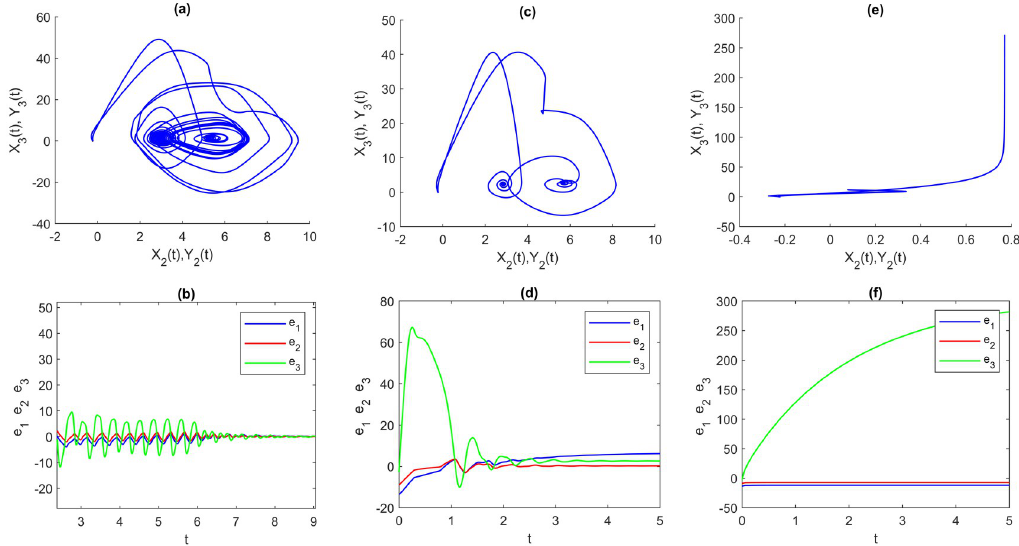
Fig 7. Multi-time delay of multi-FONNSMD synchronization with different value of parameters. (a) A = P = diag[1 1 1], (c) A = diag[1 2 2], P = diag[2 2 2], and (e) A = diag[10.5 10.5 0.5], P = diag[20.5 20.5 20.5]. (a), (c) and (e) are synchronization of FONNSMD systems while (b), (d) and (f) are dynamic error of FONNSMD systems.